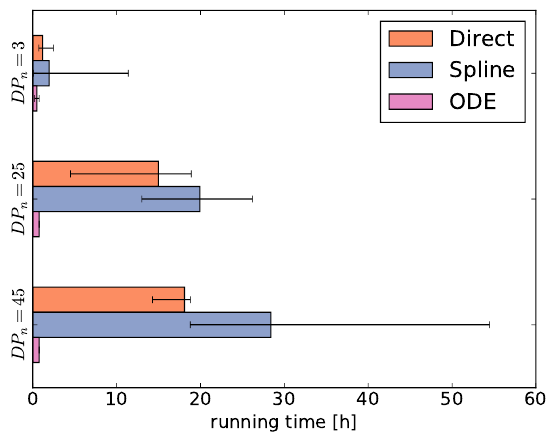
Figure 4. Running times of the optimizations averaged over all datasets with degree of polymerization DP n = 3, 25, and 45 for each fingerprint-generating function (direct, spline,